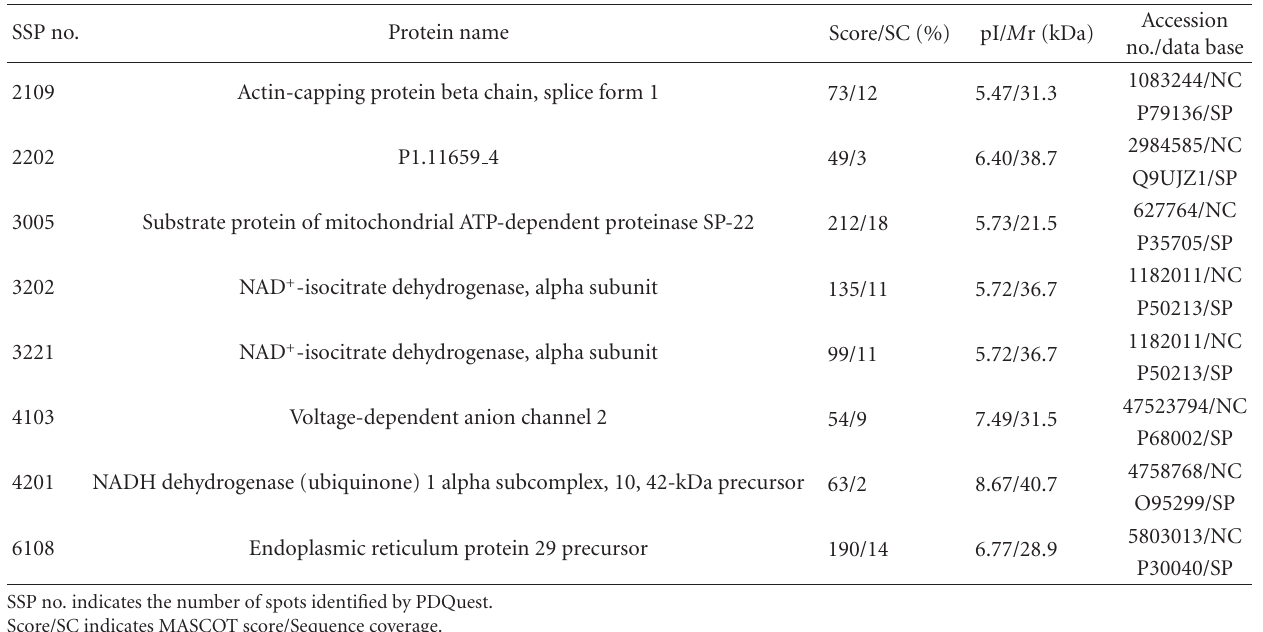
Table 3: Upregulated proteins in heterozygote GalT KO liver.